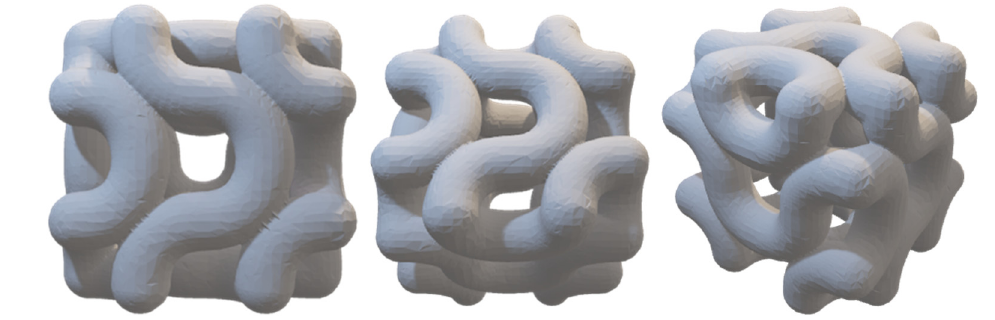
Figure 4. Algorithmically generated model using Rhino 7.